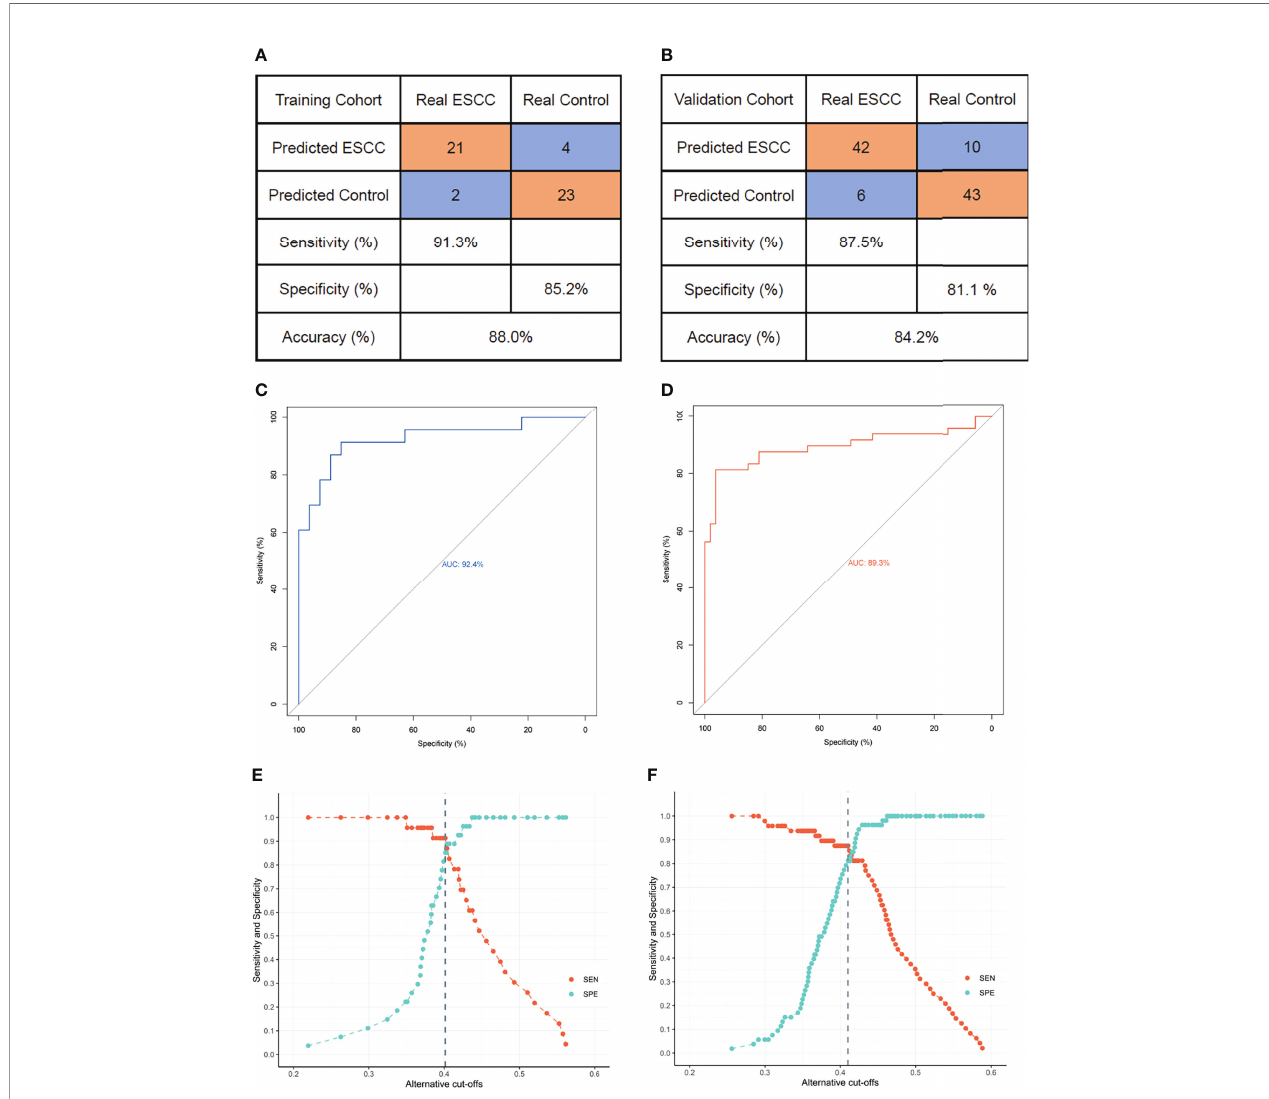
FIGURE 2 | The three-gene panel diagnostic performance with alternative cutoffs in training cohort and validation cohort. (A) Confusion matrix of SVM/LOOCV diagnostic model between ESCC and the control group in the training cohort. The sensitivity, speci fi city, and ACC for the training cohort were 91.3%, 85.2%, and 88.0% respectively. (B) Confusion matrix of SVM/LOOCV diagnostic model between ESCC and the control group in validation cohort. The sensitivity, speci fi city, and ACC for the validation cohort were 87.5%, 81.1%, and 84.2%, respectively. (C) ROC curve of the SVM/LOOCV diagnostic model in the training cohort. Area under curve was 92.4% (95% CI, 0.84.5 – 0.956). (D) ROC curve of the SVM/LOOCV diagnostic model in validation cohort. Area under curve was 0.893% (95% CI, 0.821 – 0.966). (E) Sensitivity and speci fi city of the three-gene diagnostic model using alternative cutoffs in the training cohort. (F) Sensitivity and speci fi city of the three-gene diagnostic model using alternative cutoffs in validation cohort. Gray dashed line indicates the highest Youden index obtained when selecting the appropriate cutoff value. ACC, accuracy; AUC, area under curve; ESCC, esophageal squamous cell carcinoma; LOOCV, leave-one-out cross-validation; SVM, support vector machine; ROC, receiver operating